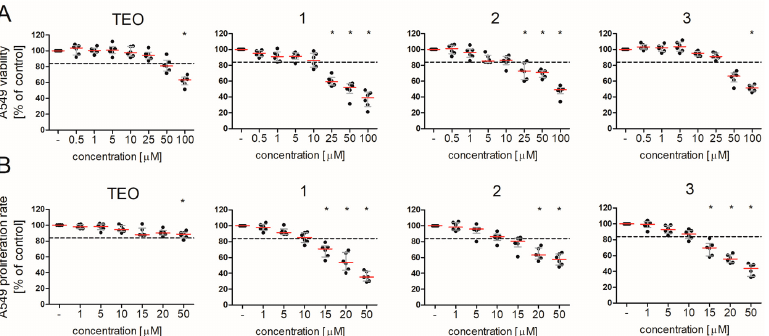
Figure 3. Pan-PDE inhibitors affect A549 cells’ viability and proliferation rate. A549 cells were cultured overnight and then incubated in growing concentrations of 1 , 2 , 3 , and TEO. Cell viability was determined by the MTT assay ( A ) and the cell proliferation rate was assessed by crystal violet nuclei staining ( B ) after 48 h of incubation with the tested compounds. Horizontal line represents the median with interquartile range (in comparison to non-treated cells normalized to 100%), n = 6 (Kruskal–Wallis test with Dunn’s post-hoc test). The dashed lines mark the values above which the tested compounds were considered non-toxic ( A ) and did not affect cell proliferation ( B ). The results were considered statistically significant at the p -level of 0.05